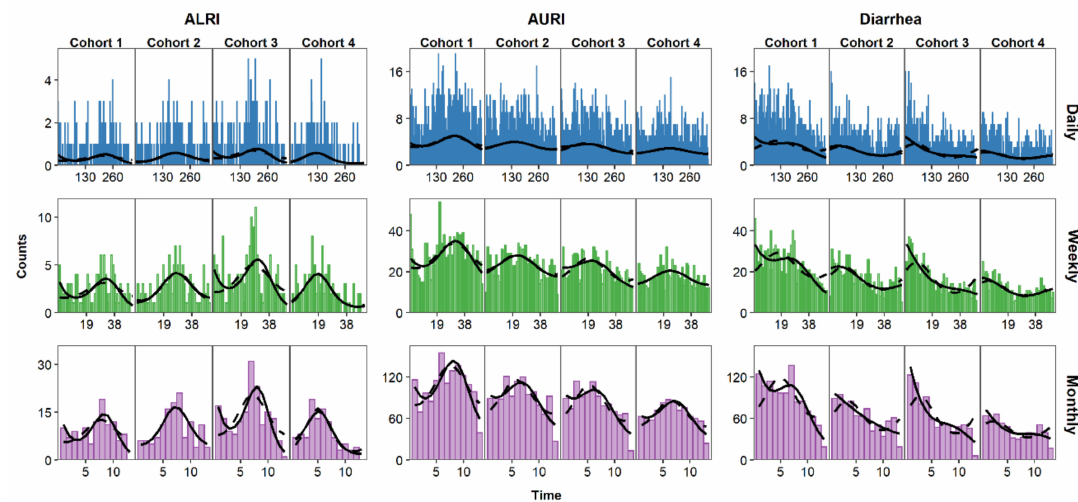
Figure 5. Time series plots showing modeled seasonality as a dashed line and modeled seasonality plus trend as a solid line for daily, weekly, and monthly counts of AURI, ALRI, and diarrhea.